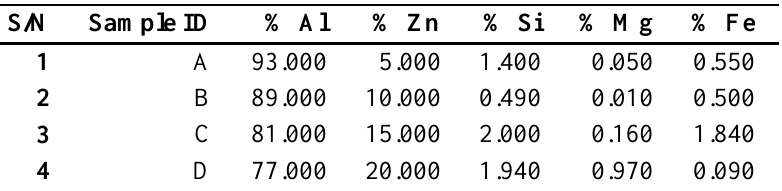
Table 2. Spectrometry